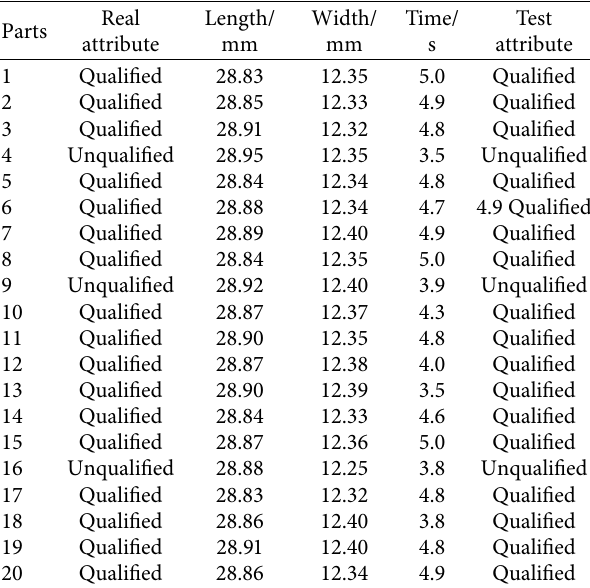
Table 1: Actual measurement of 20